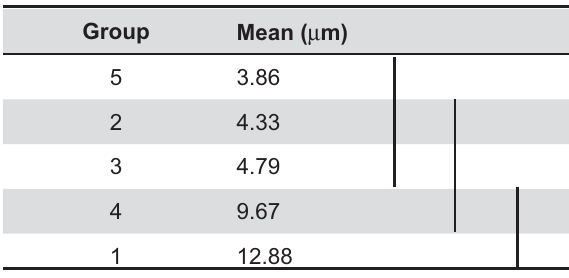
Groups joined by a vertical bar did not present any